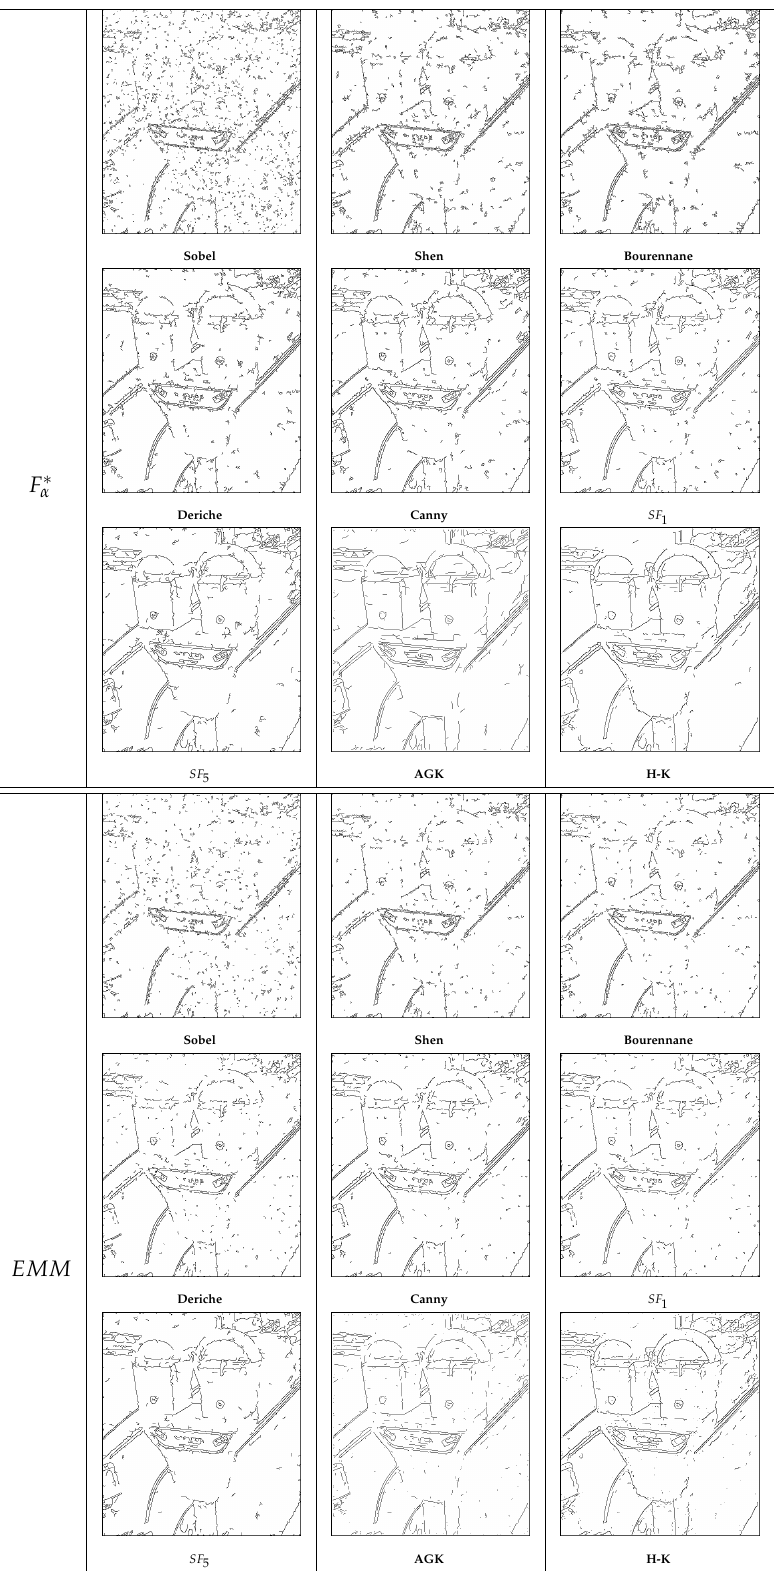
Figure 37. Ideal segmentations for several edge detectors on image parkingmeter, PSNR = 14